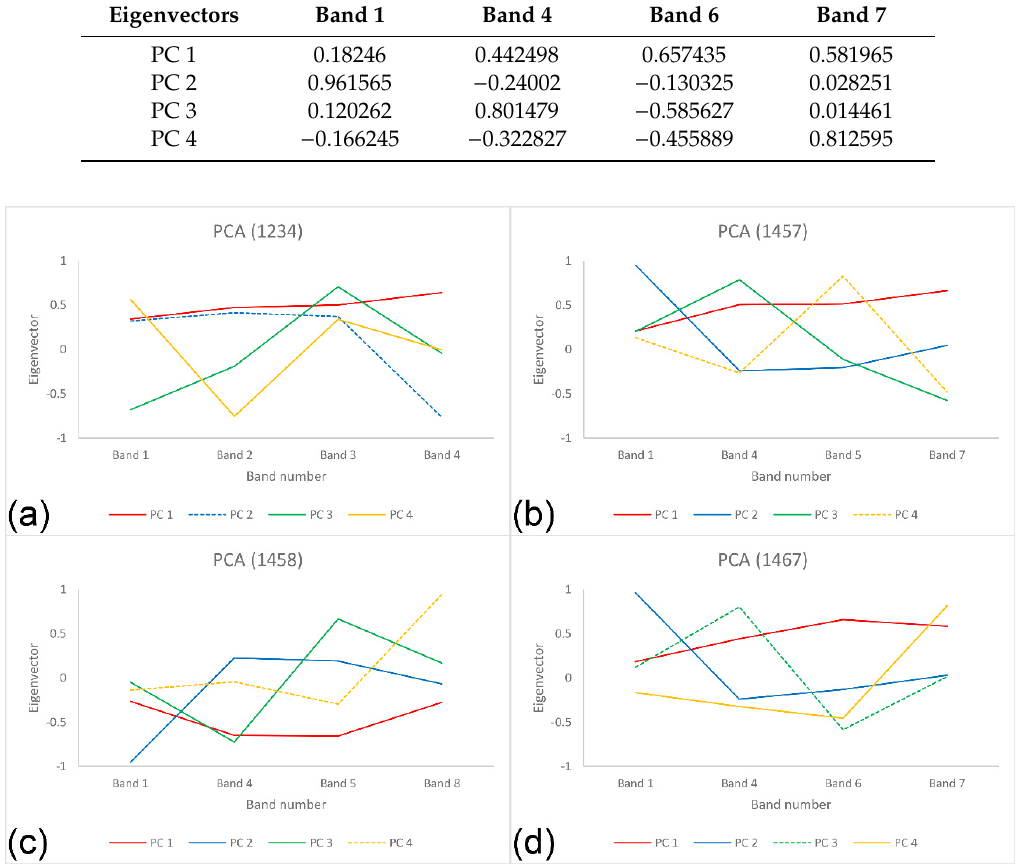
Figure 4. Trends of eigenvectors related to the selective principal component analysis on the ASTER spectral bands presented in Tables 1–4, are shown in a–d, respectively.